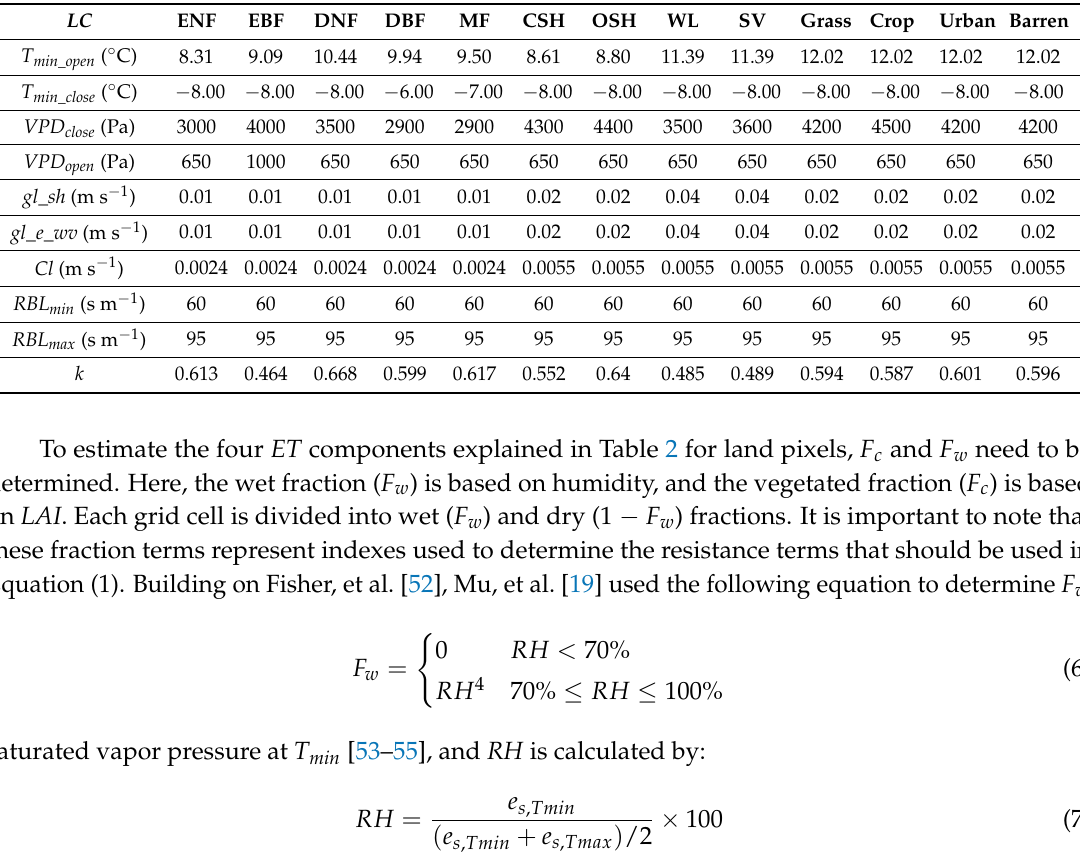
Table 3. Biome specific parameter look-up table for Evergreen Needleleaf Forest (ENF), Evergreen Broadleaf Forest (EBF), Deciduous Needleleaf Forest (DNF), Deciduous Broadleaf Forest (DBF), Mixed Forest (MF), Closed Shrublands (CSH), Open Shrublands (OSH), Woody Savannas (WL), Savannas (SV), Grasslands (Grass), Croplands (Crop), Urban and Built-up (Urban), and Barren or Sparsely Vegetated (Barren); T min_open , T min_close , VPD open , VPD close determine boundary conditions for mT min and mVPD multipliers, which control transpiration, gl_sh and gl_e_wv are leaf conductance terms and Cl is a stomatal conductance term, RBL min and RBL max are boundary conditions that control soil resistance terms. See Mu, et al. [19] for more details. Light extinction coefficient ( k ) will be explained later. LC ENF Grass Crop Urban Barren